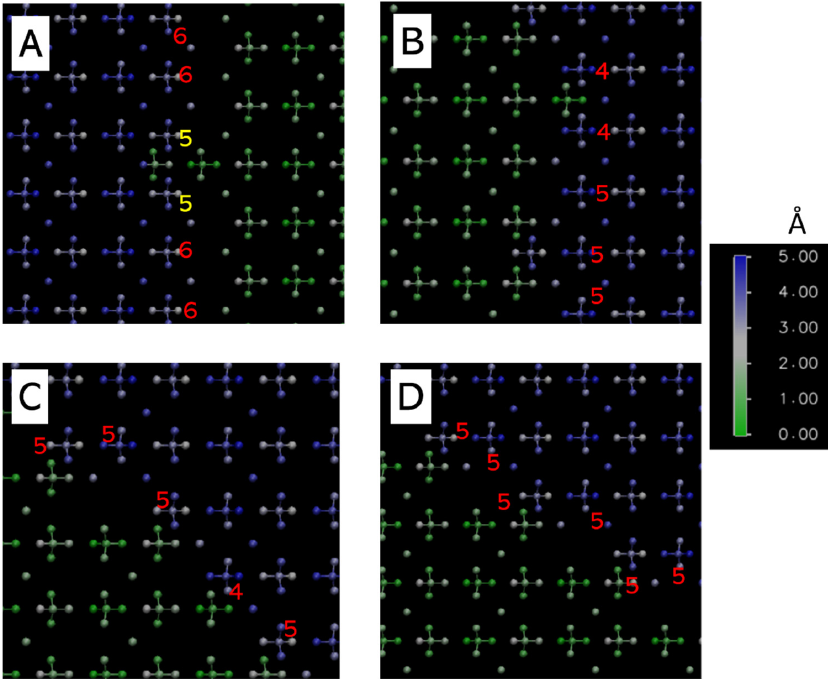
Figure 6. Structure of steps and coordination of SO 4 step sites, number colors denote step type: red for step sites, yellow for kink sites. ( A ): [010] left step (slow); ( B ): [010] right step (fast); ( C ): [2(cid:3364)10] straight step; ( D ): [2(cid:3364)10] segmented step.